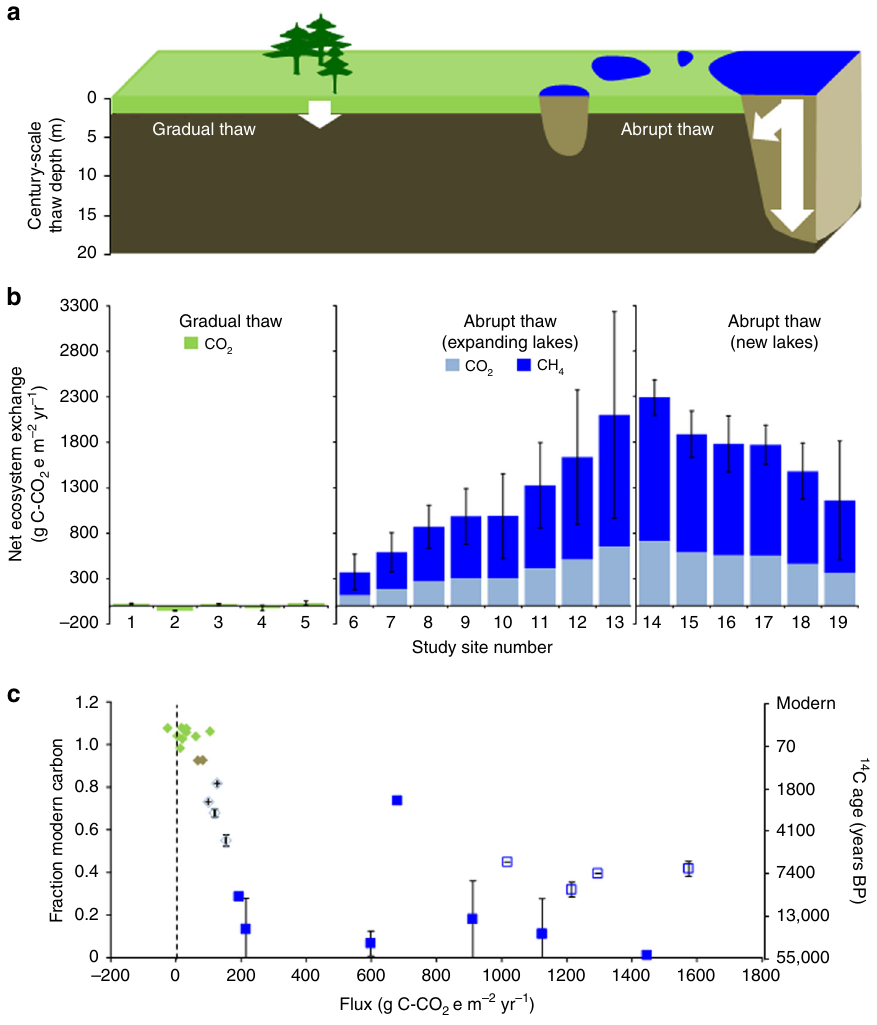
Fig. 2 Comparison of gradual, top-down thaw in upland permafrost and abrupt thaw beneath lakes. a Schematic. b Field measurements of net ecosystem exchange (NEE) in Greenland (#1,2) 28 , Healy, Alaska (#3 – 5) 26 , western Alaska (#6 – 9), interior Alaska (#10,11,14 – 19) and northeast Siberia (#12,13); standard error bars. c Radiocarbon-dated CO 2 from gradual thaw NEE 26,28 (green), including speci fi cally the old soil carbon component 27 (brown). Radiocarbon-dated CO 2 in ebullition bubbles of new abrupt thaw lakes formed since 1949 (blue, open diamonds). Also in c , abrupt thaw CH 4 emitted as bubbles from expanding lake margins 21 (blue fi lled squares) and new lakes (blue open squares). In c , standard errors of the mean are shown for n ≤ 27 individually dated ebullition events per lake on 11 lakes (Supplementary Data 2). NEE and radiocarbon ages associated with abrupt thaw were higher than those of gradual thaw (Kolmogorov-Smirnov test, p <